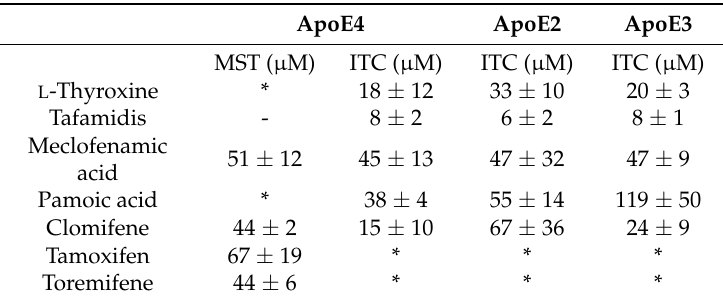
Table 1. Binding affinities determined by MST and